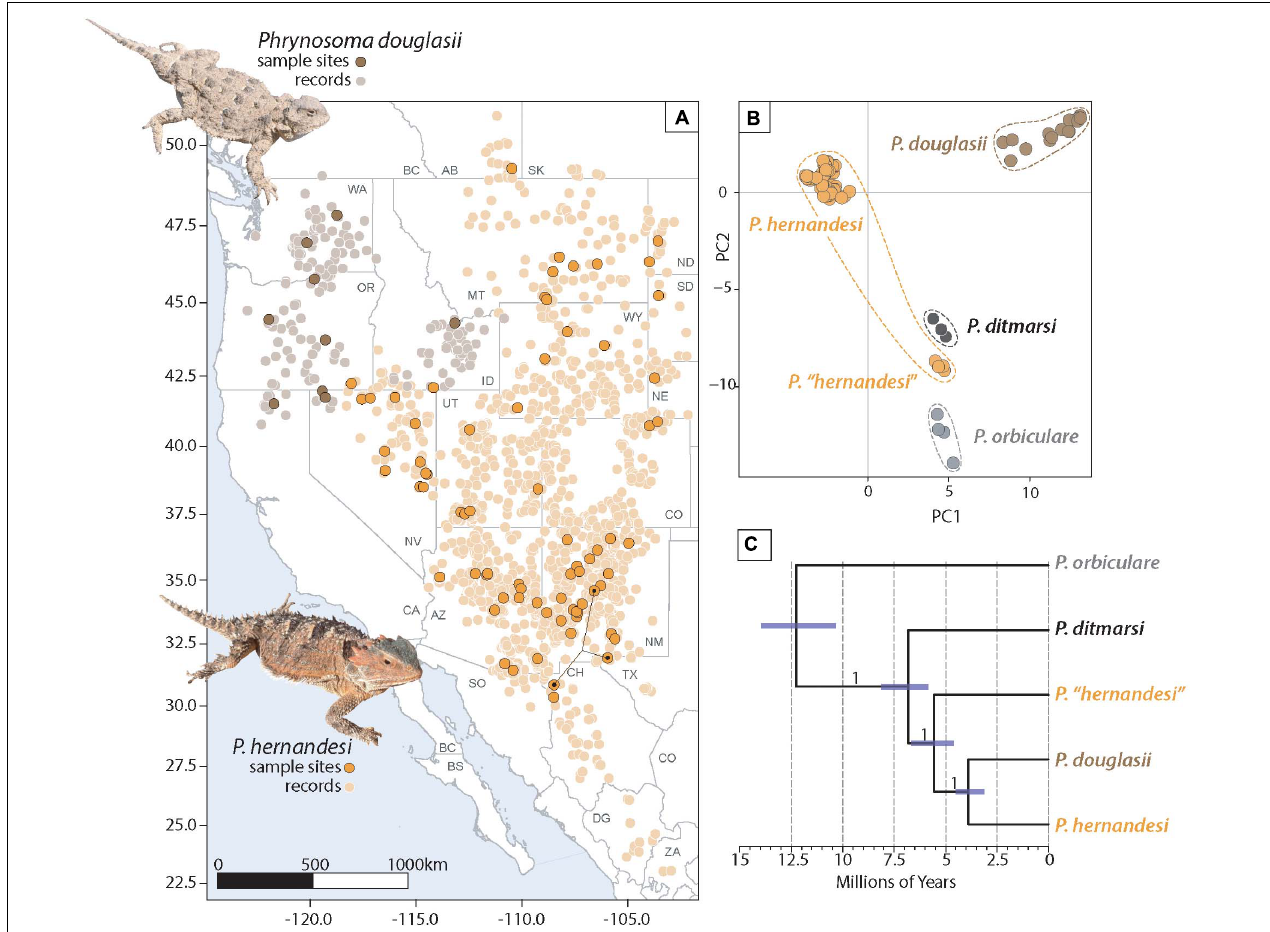
FIGURE 2 | Analyses of multilocus nuclear data focusing on Phrynosoma douglasii and P. hernandesi. (A) Geographic distribution of P. douglasii and P. hernandesi in Western and Central North America. Distributional data are based on published locality records and distribution maps (Montanucci, 2015) and augmented with records downloaded from VertNet.org and iNaturalist. Detailed information on sample sites included in the phylogeographic component of this study are provided in Supplementary Table 2 . (B) Principal components analysis of genetic variation (5,715 biallelic SNPs) for the species belonging to the Tapaja clade of Phrynosoma . The 94 P. hernandesi samples form two genetic clusters; the majority of the samples belong to P. hernandesi ( n = 90), while P. “ hernandesi ” only includes four samples from the southern portion of the range with localities in New Mexico, Texas, and Mexico (shown on map with connected black dots). (C) A time-calibrated species tree analysis using the biallelic SNP data supports the paraphyly of P. hernandesi with respect to P. douglasii . Numbers on nodes are posterior probability